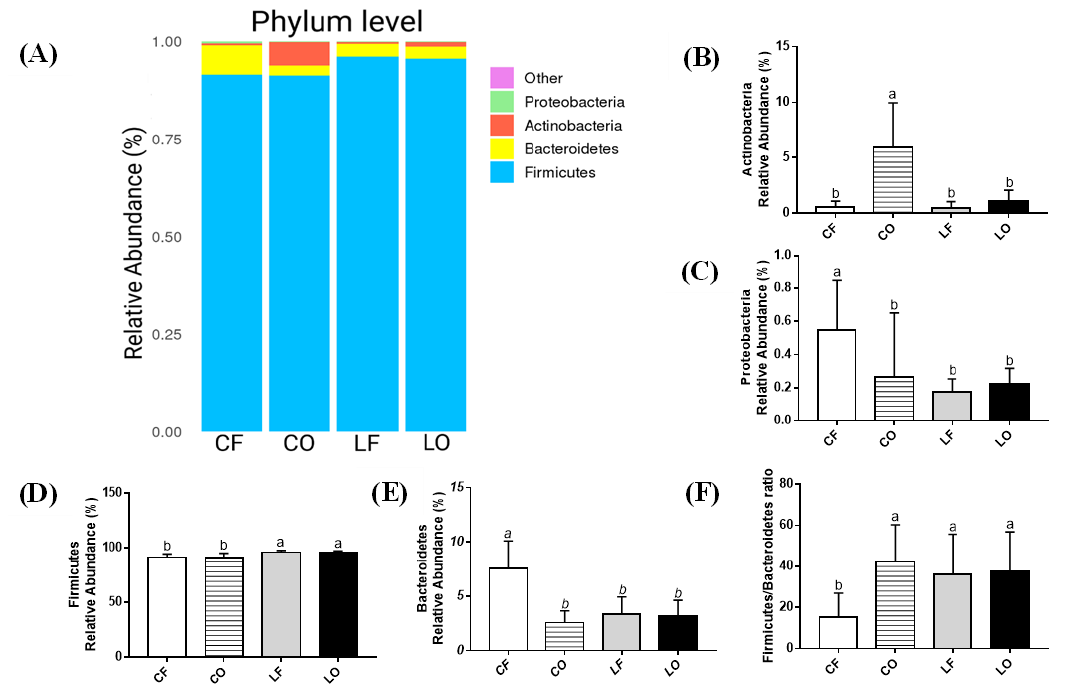
Figure 7. Phylum level changes in bacterial composition (>0.01%) of hamsters fed one of the four diets: CF, fresh corn oil; CO, oxidized corn oil; LF, fresh lard; LO, oxidized lard. ( A ) Bar plot of relative abundance (%). Comparison in abundances of: ( B ) Actinobacteria, ( C ) Proteobacteria, ( D ) Firmicutes, and ( E ) Bacteroidetes. ( F ) Ratio between Firmicutes and Bacteroidetes. Data are expressed as mean ± S.D., where different letters indicate statistical difference, p < 0.05.